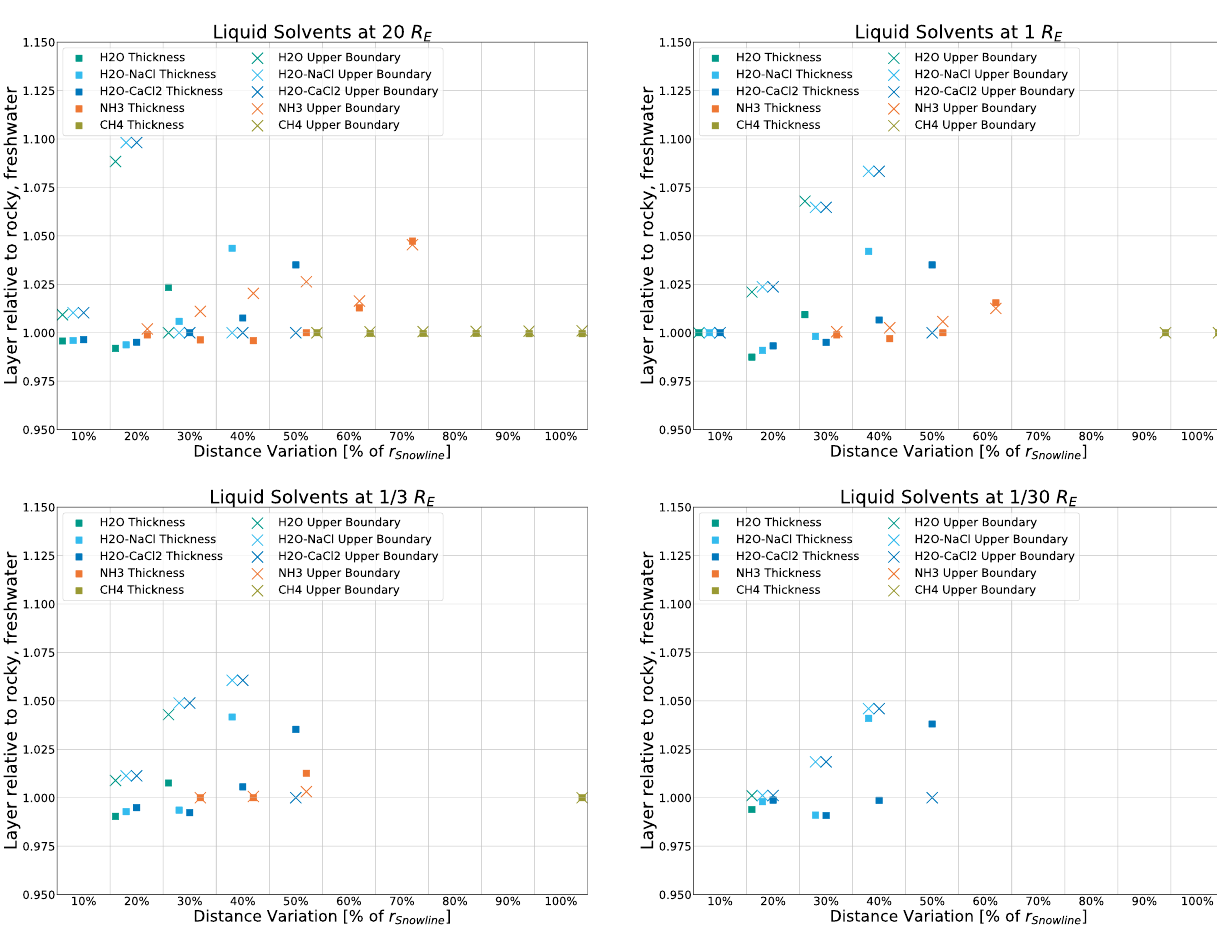
Figure A2. Deviation from the rocky, freshwater model for liquid layer thickness and upper boundary for an icy